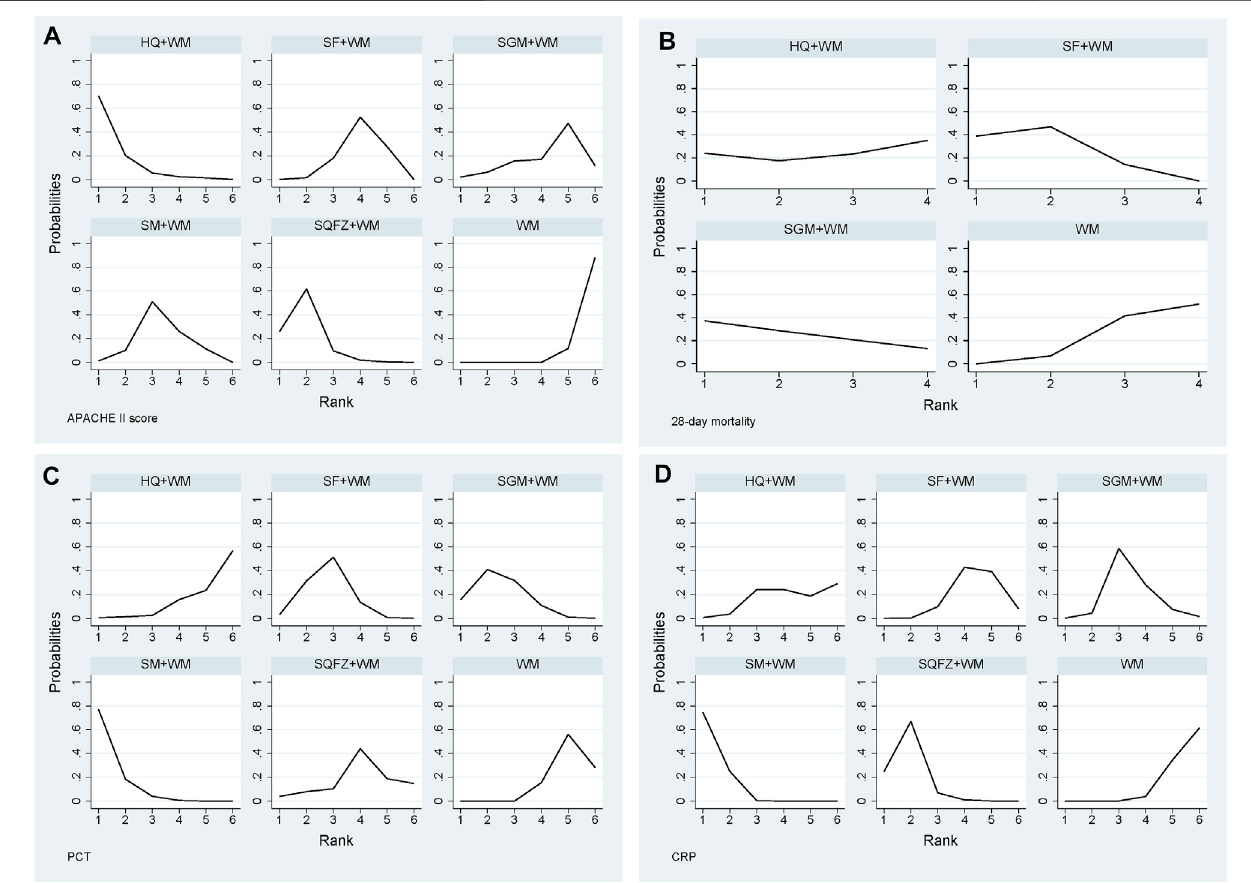
FIGURE 4 | Plot of SUCRA for all different outcomes. Note: (A) : APACHE II score; (B) : 28-days mortality; (C) : PCT; (D) : CRP; (E) : IL-6; (F) : TNF- α ; (G) : CD4 + ; (H) : CD8 + ; (I) : CD4 + /CD8 + .